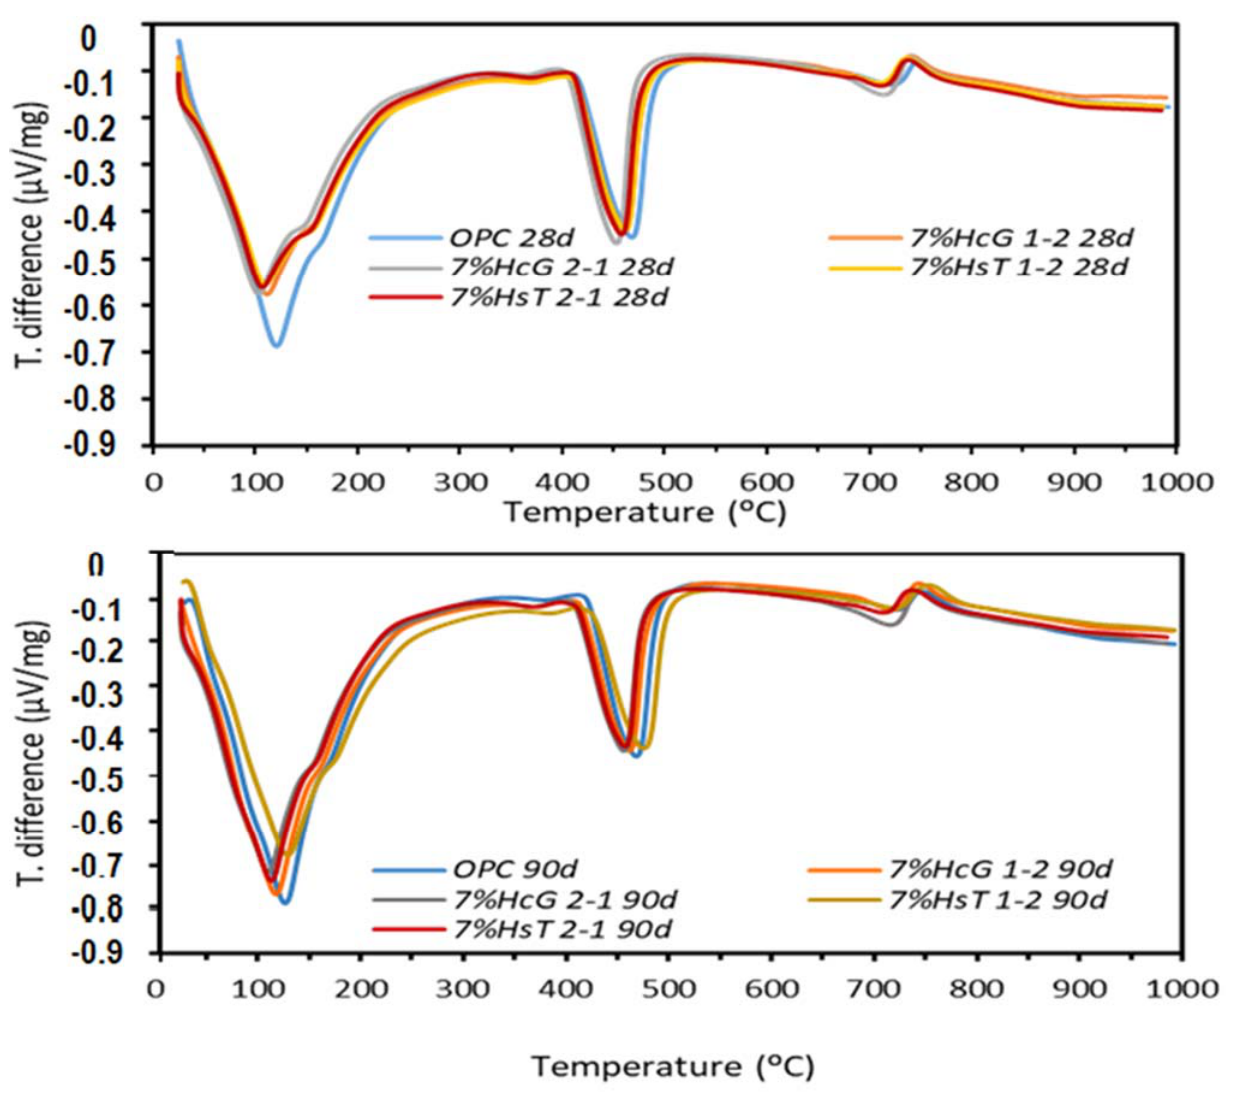
Figure 3. TG/DTA curves at 28 and 90 days of treatment from ternary hydrated cement. Figure 3. TG/ DTA curves at 28 and 90 days of treatment from ternary hydrated cement. The second endothermal zone, stretching from 400 ◦ C to 550 ◦ C and peaking at 463 ◦ C, The mass loss recorded from the TG/DTA curves at temperature intervals 50/400 °C, was typical of portlandite dehydroxylation and the third, at 550 ◦ C to 750 ◦ C with a peak 400/550 °C, and 550/750 °C is listed in Table 9, which also gives the relative portlandite close to 720 ◦ C, of carbonate decarbonation content of each sample, given the 7% replacement of the reference OPC. Table 9. Mass loss (%) by temperature range and relative Ca(OH) 2 content (%) in the pastes stud ‐ ied.